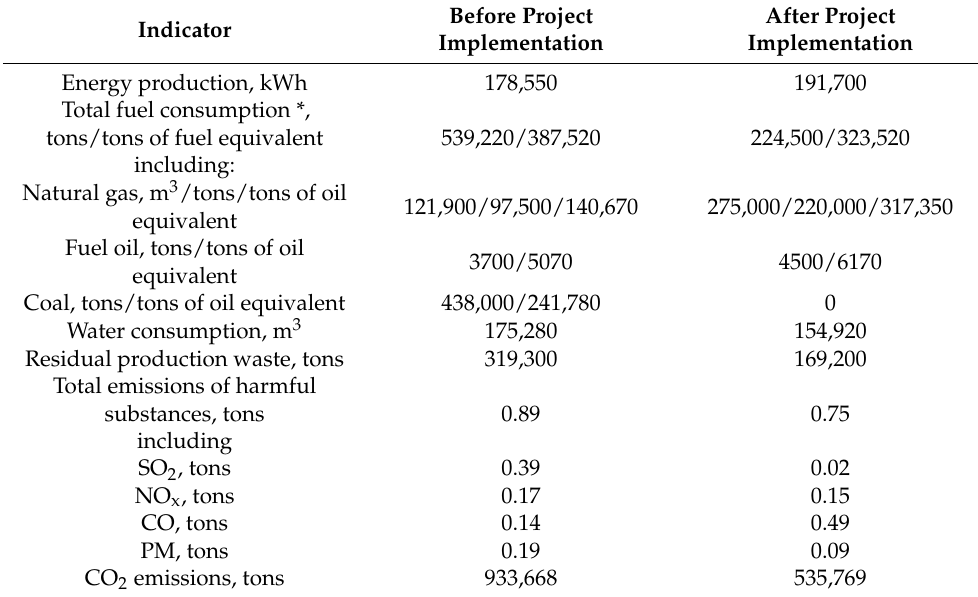
Table 2. Key indicators of the CHP X operation before and after investment project implementation. Before Project After Project Indicator Implementation Implementation Energy production, kWh